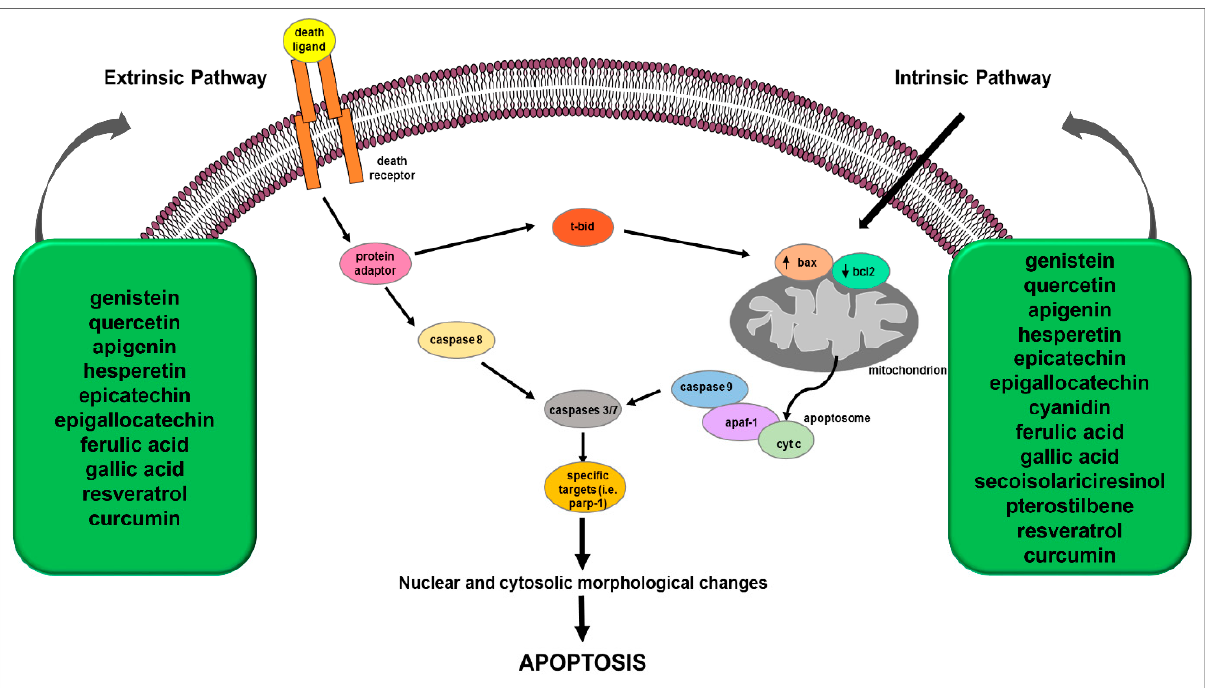
Figure 2. Effects of some polyphenols on extrinsic and intrinsic apoptotic pathways in cancer. ↑ : increase, ↓ : decrease. Adapted from Chimento, A. et al.